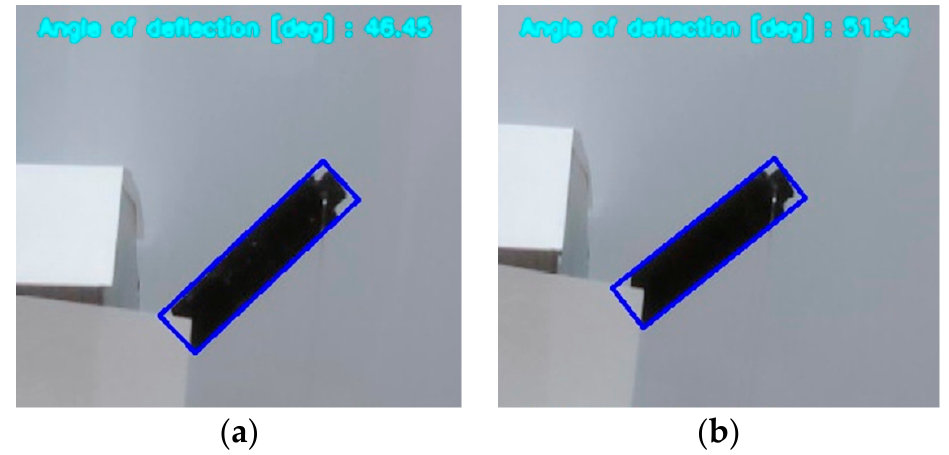
Figure 14. Example of computer vision measured bending angle θ for compliant finger with ( a ) curved flexure hinge with a 21-degree bend and ( b ) curved flexure hinge with a 90-degree bend, for a loaded 30 g weight.